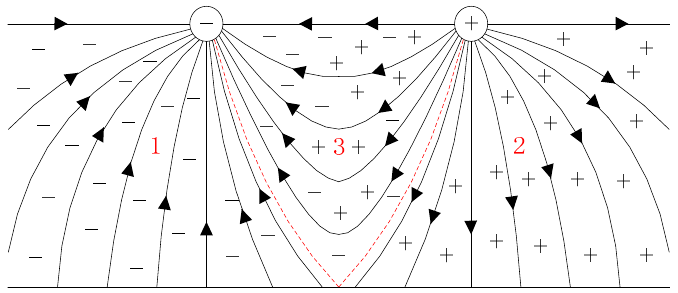
Figure 1. Space charge distribution around direct current transmission lines.